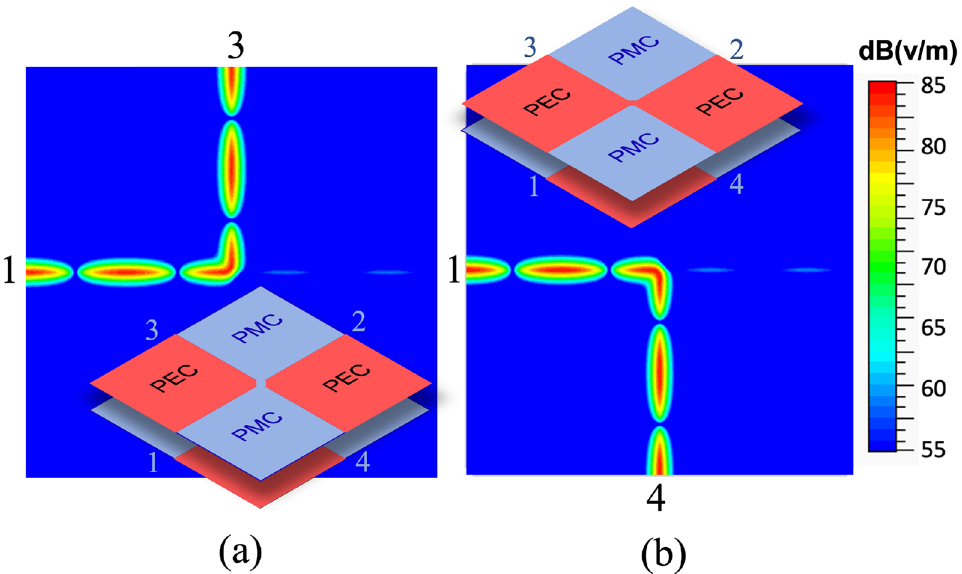
Figure 3. Amplitude of the electric field in the ideal 4-Ports junction for dual BCs on the central gap, as shown in the insets, simulated with Ansys HFSS 2020 30